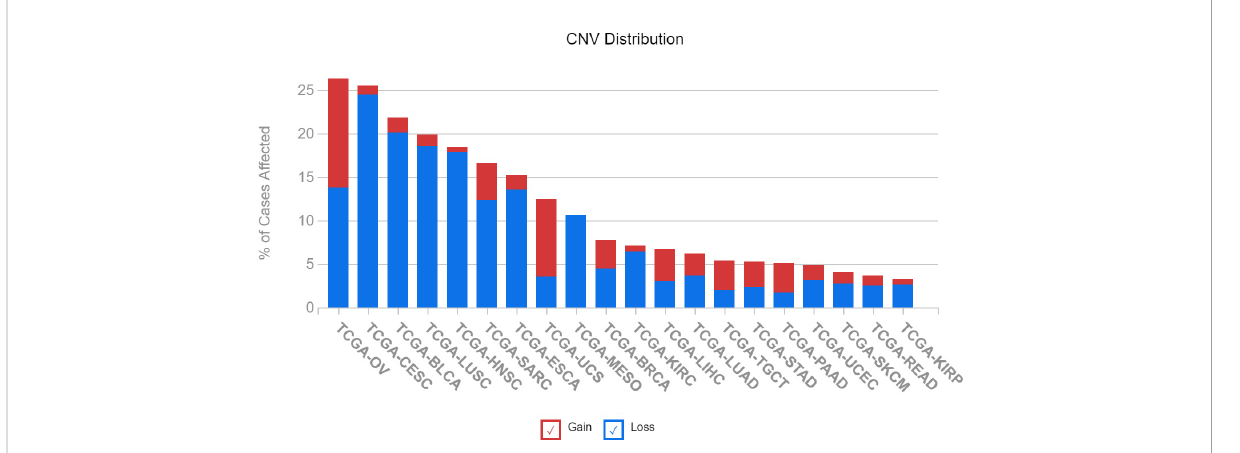
FIGURE 6 Copy number variation of IGFBP5 is most prevalent in gynecologic cancers in patients from The Cancer Genome Atlas (TCGA) and can result in both gain and loss of function. Illustrates the number of cases of altered IGFBP5 gene across 20 TCGA cancer types (BLCA, bladder urothelial carcinoma; BRCA, breast invasive carcinoma; CESC; cervical squamous cell carcinoma and endocervical adenocarcinoma; ESCA, esophageal carcinoma; HNSC, head and neck squamous cell carcinoma; KIRC, kidney renal clear cell carcinoma; KIRP, kidney renal papillary cell carcinoma; LIHC, liver hepatocellular carcinoma; LUAD, lung adenocarcinoma; LUSC, lung squamous cell carcinoma; MESO, mesothelioma; OV, ovarian serous cystadenocarcinoma; READ, Rectum adenocarcinoma; SARC, sarcoma; SKCM, skin cutaneous melanoma; STAD, stomach adenocarcinoma; TGCT, testicular germ cell tumors; PAAD, pancreatic adenocarcinoma; UCEC, uterine corpus endometrial carcinoma; UCS, uterine